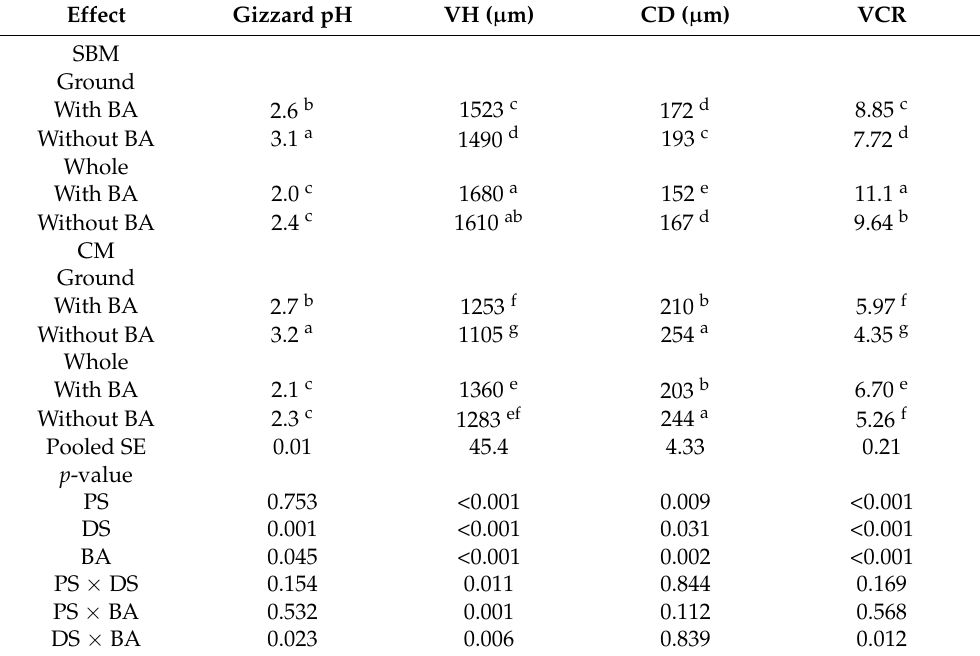
Table 4. Effect of protein source (PS), diet structure (DS) and butyric acid (BA) supplementation on gizzard pH, villus height (VH), crypt depth (CD) and villus height-to-crypt depth ratio (VCR) in broilers 1 at 36 days of age.